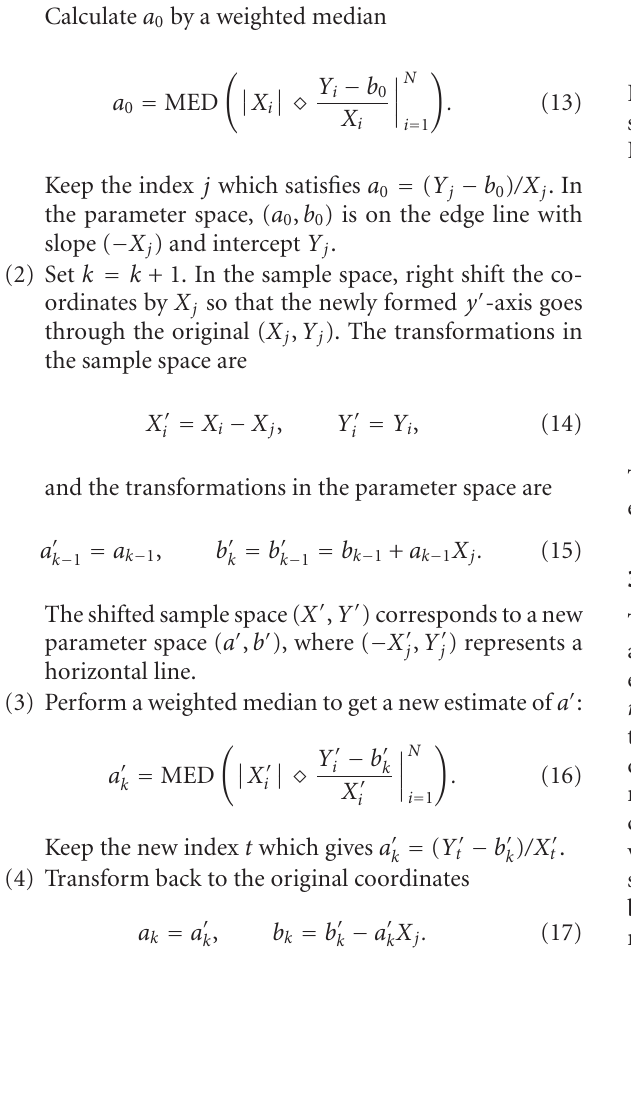
Figure 4: Illustration of one iteration. The previous estimate ( a k − 1 , b k − 1 ) is mapped into the transformed coordinates as ( a (cid:4) k − is obtained through ML estimation in the transformed coordinates; the new estimate ( a k , b k ) is formed by mapping ( a (cid:4) k , b (cid:4) k ) back into the original coordinates. The sample set is [(1 . 6,2 . 8), ( − 1 . 4, − 3 . 8), (1 . 2,3 . 5), ( − 4 . 3, − 4 . 7), ( − 1 . 8, − 2 .